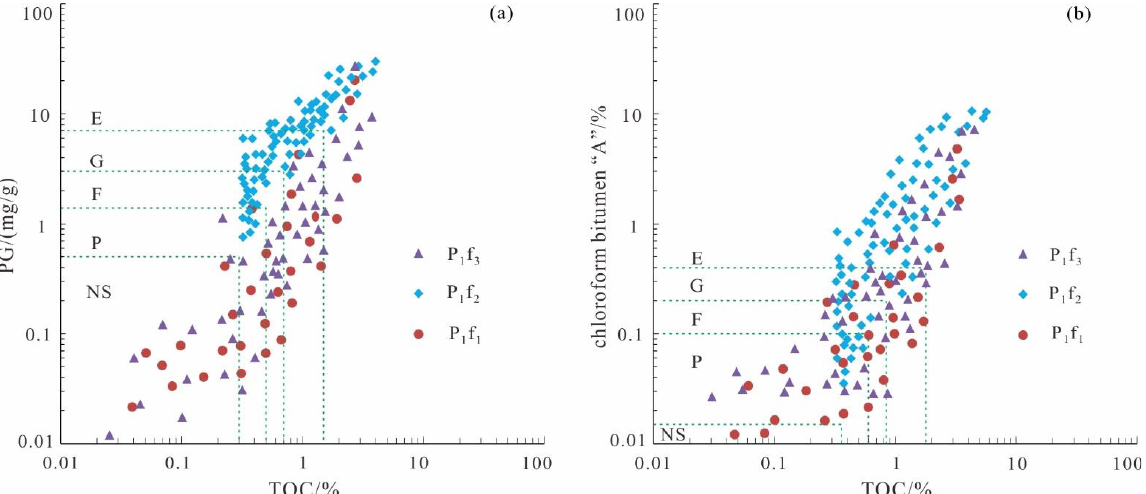
Figure 10. Source rock evaluation of the Fengcheng Formation in the Mahu Sag: ( a ) PG versus TOC; ( b ) chloroform bitumen “A” versus TOC. NS: non-source rocks; F: fair source rocks; G: good source rocks; VG: very good source rocks; E: excellent source rocks.